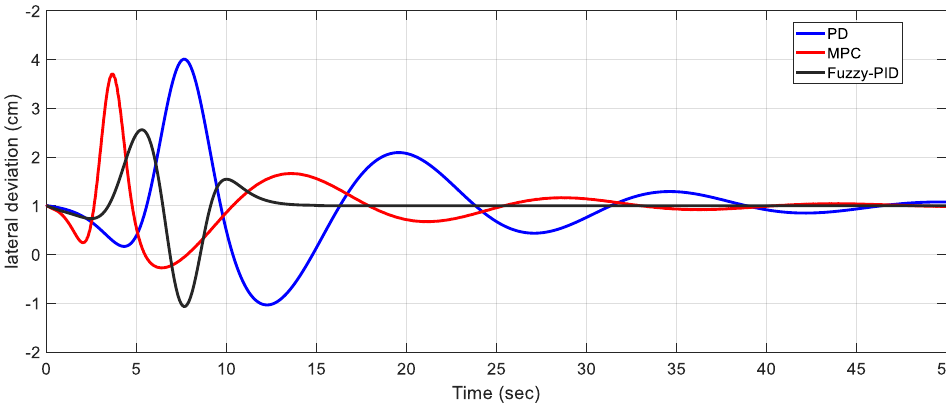
Figure 8. Comparison of PD, MPC, and fuzzy-PID.